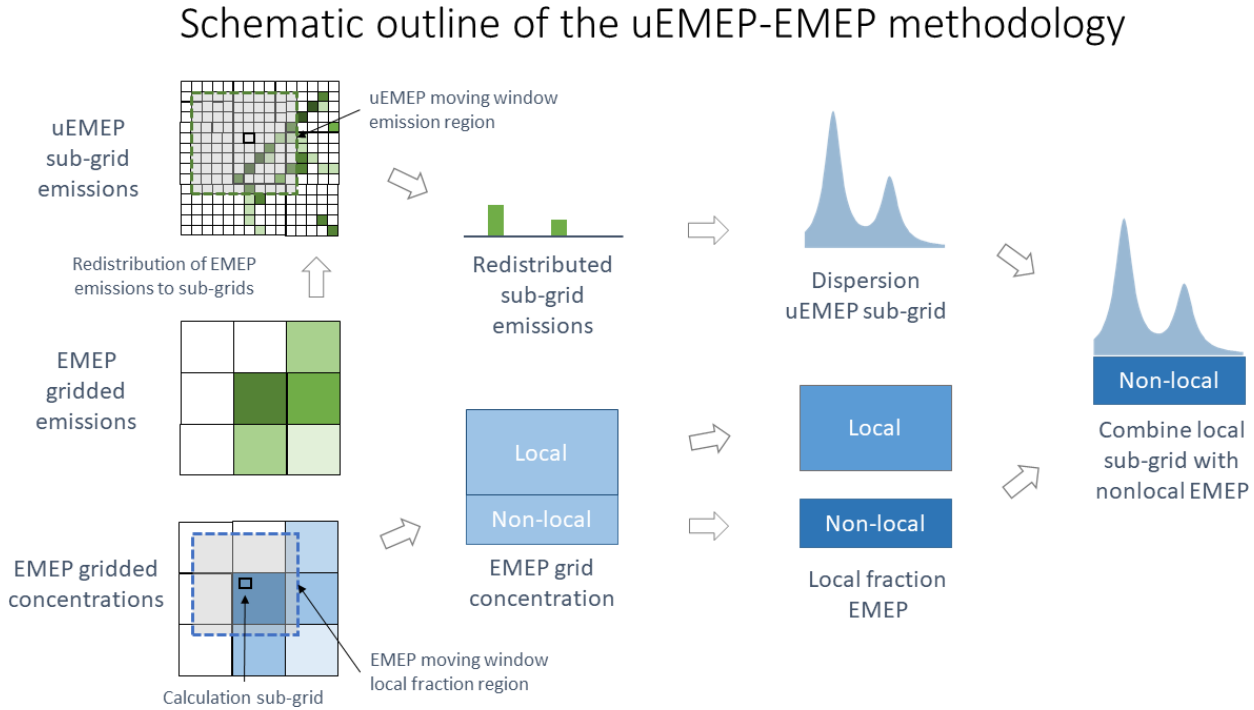
Figure 1. Schematic illustration of the uEMEP–EMEP coupled modelling system.